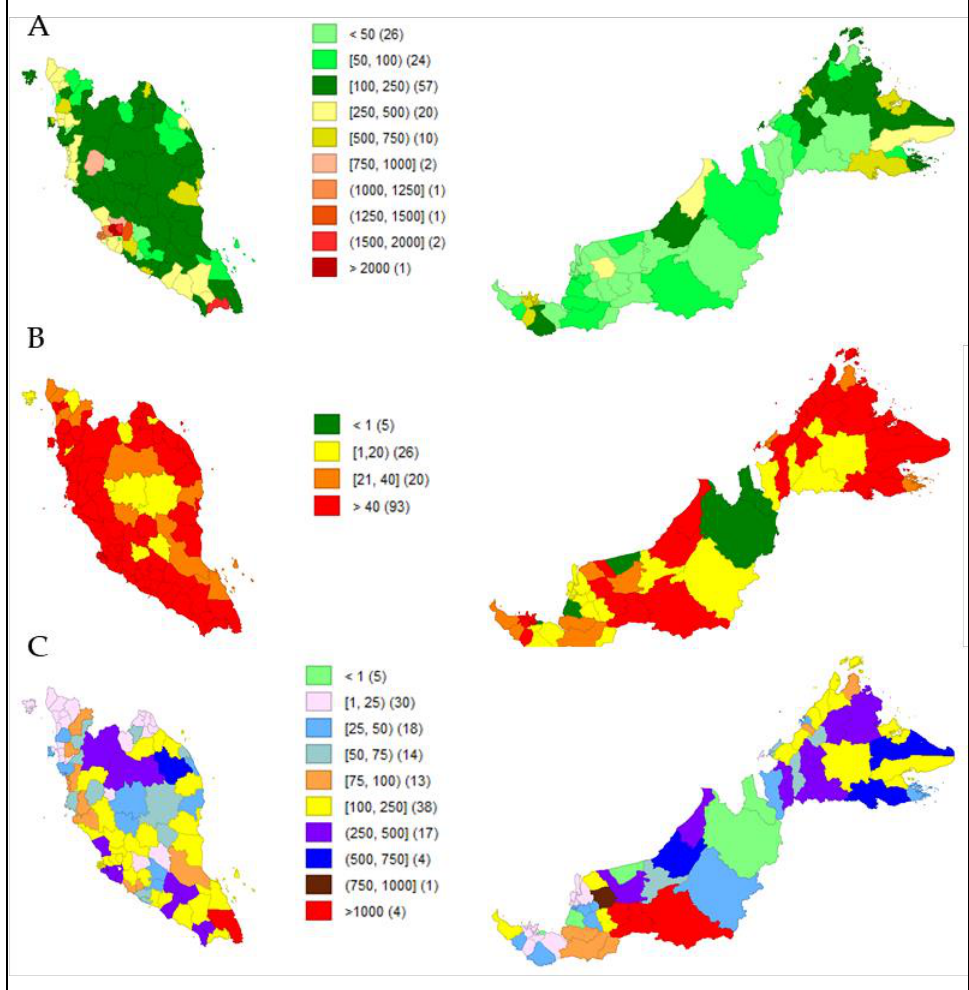
Figure 2. Choropleths showing district-wise heat distribution based on ( A ) total inhabitants per 1000 population (comparator); ( B ) total active cases ( n = 51,476); ( C ) attack rate.